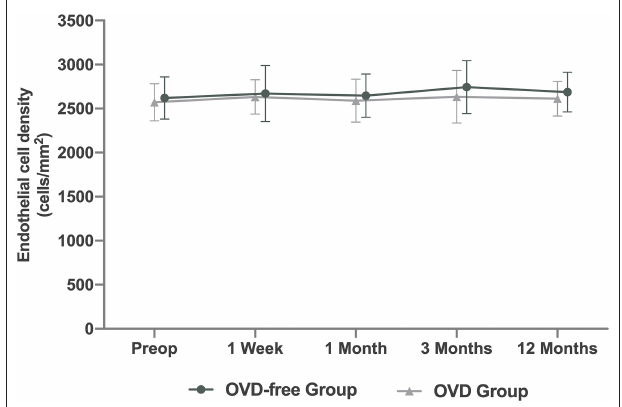
FIGURE 3 | Time course of changes in endothelial cell density (ECD) after Implantable Collamer Lens V4c implantation in ophthalmic viscosurgical device-free (OVD-free)/OVD